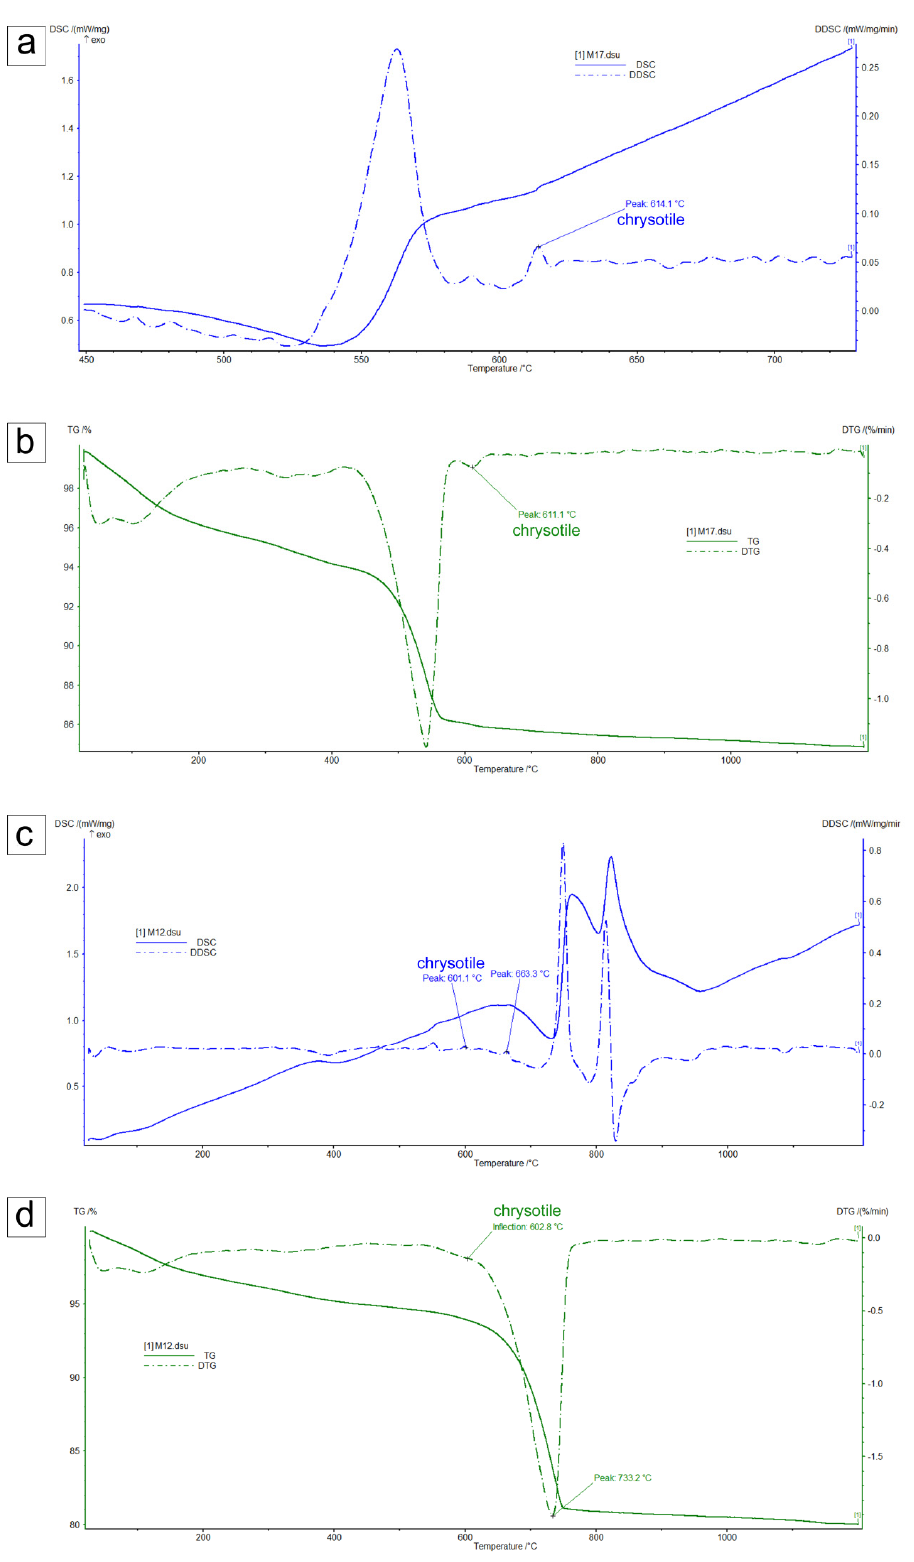
Figure 10. Thermal analysis of M ‐ 17 and M ‐ 12 samples: ( a ) sample M ‐ 17, blue solid line DSC, blue dashed line DDSC; ( b ) sample M ‐ 17, green solid line TG, green dotted line DTG; ( c ) sample M ‐ 12, blue solid line DSC, blue dashed line DDSC; ( d ) sample M ‐ 12, green solid line TG, green dotted line DTG.